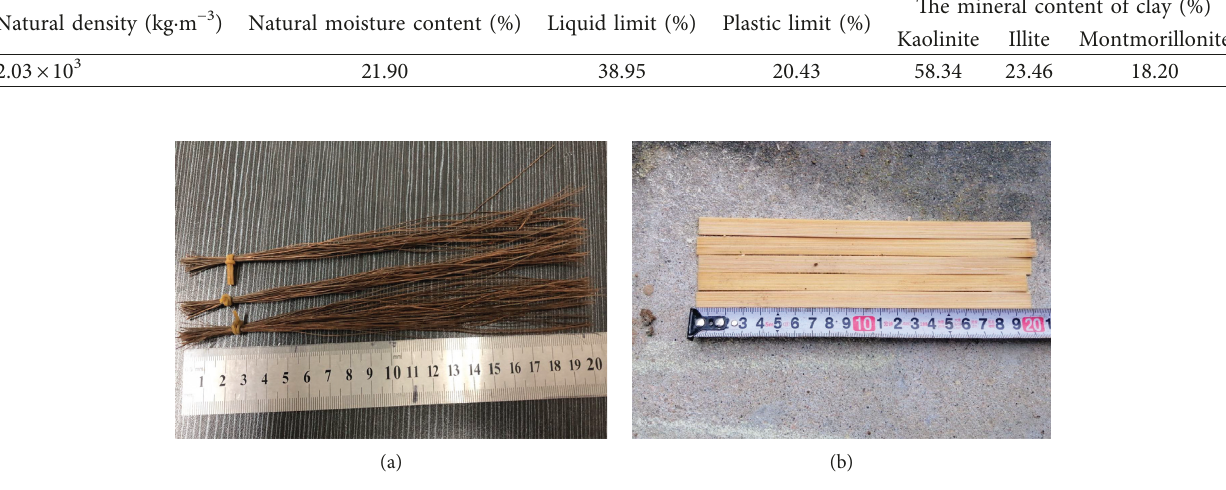
Figure 1: Different materials used in tensile tests. (a) Flax fiber. (b) Bamboo strip.